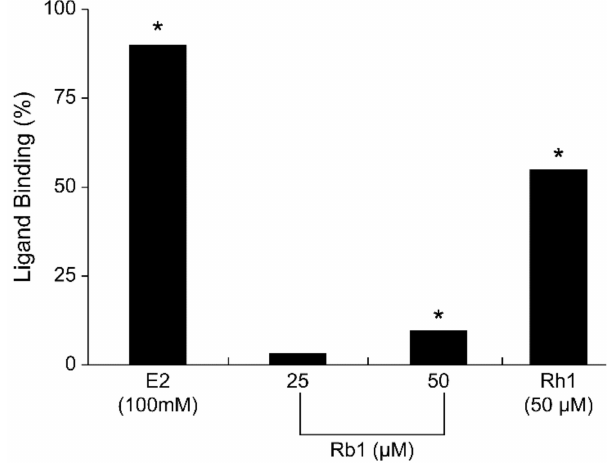
Figure 5. Binding of ginsenoside-Rb1 to ER in MCF − 7 cells. * p < 0.05. Reprinted from Cho, J.; Park,